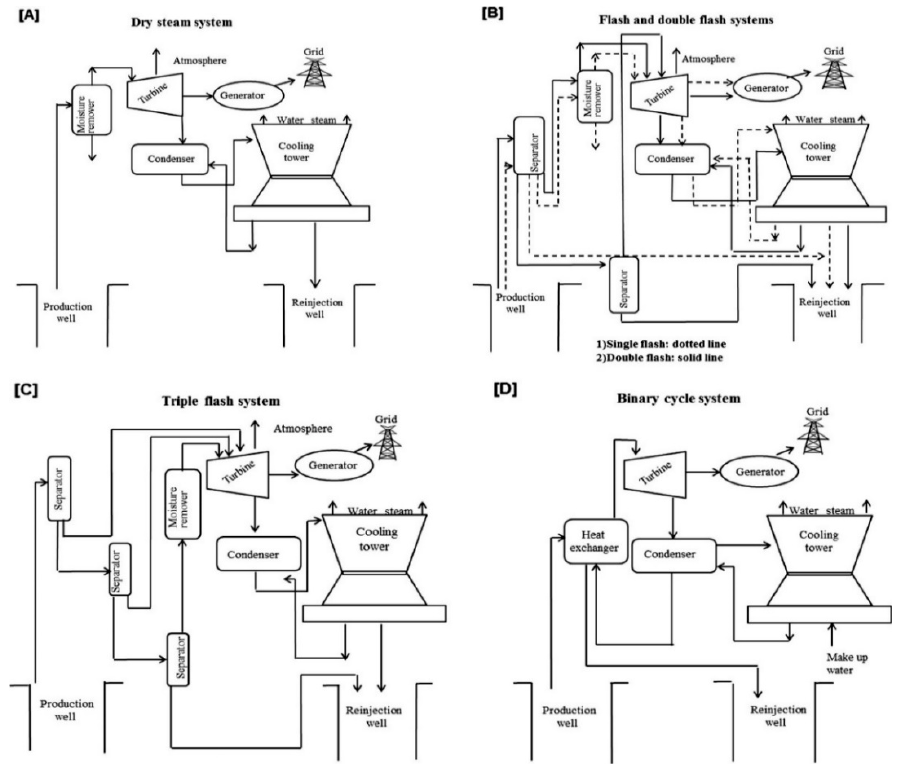
Figure 2. Simplified flow diagram for dry steam systems ( A ), single and double flash systems ( B ), triple flash system ( C ) and binary-cycle ( D ) geothermal power plant [8].